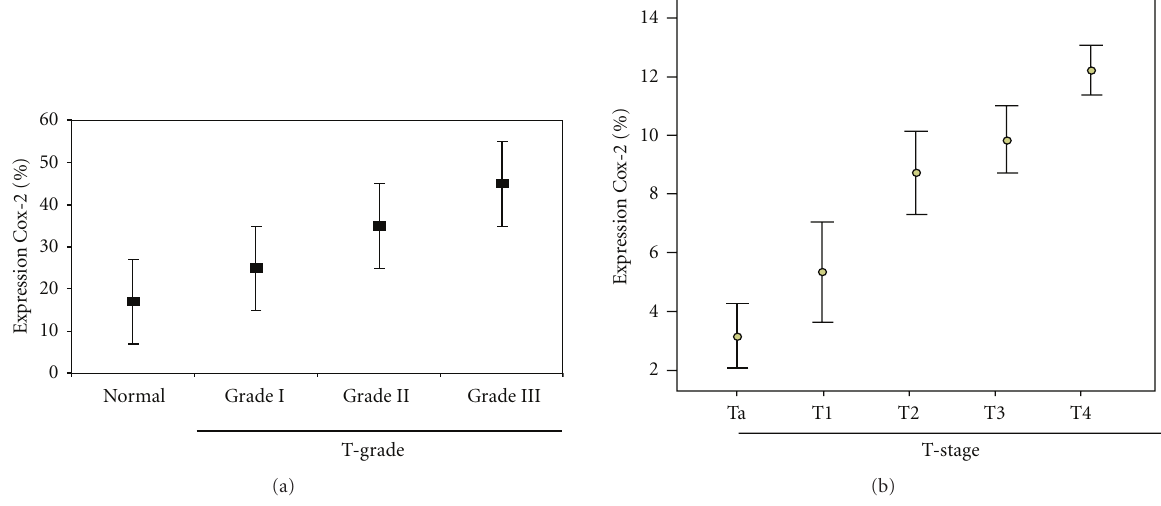
Figure 2: COX-2 in 140 patients participating in the study stratified by (a) tumor grade and (b) tumor stage . (error bars = standard error of the value). Table 2: Correlation of tumor grade with COX-2 immunostaining. High grade of bladder carcinomas exhibited strong COX-2 cytoplasmic expression. (Spearman correlation coe ffi cient r = 0 . 24 , P value < .